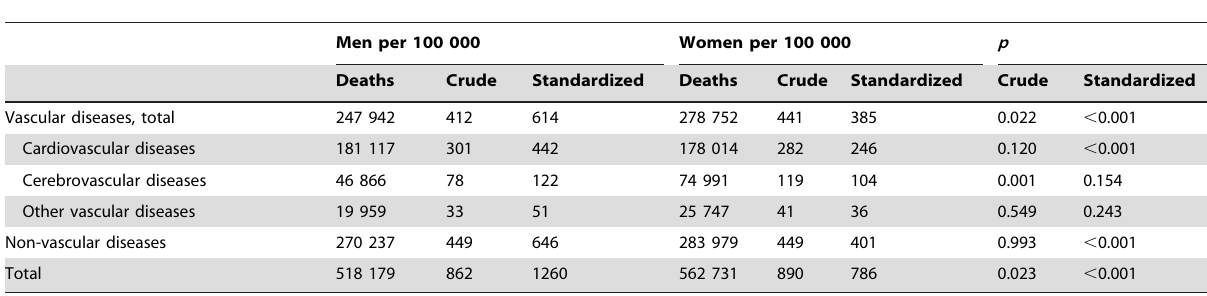
Table 1. Overall mortality among men and women, Finland 1986–2009.